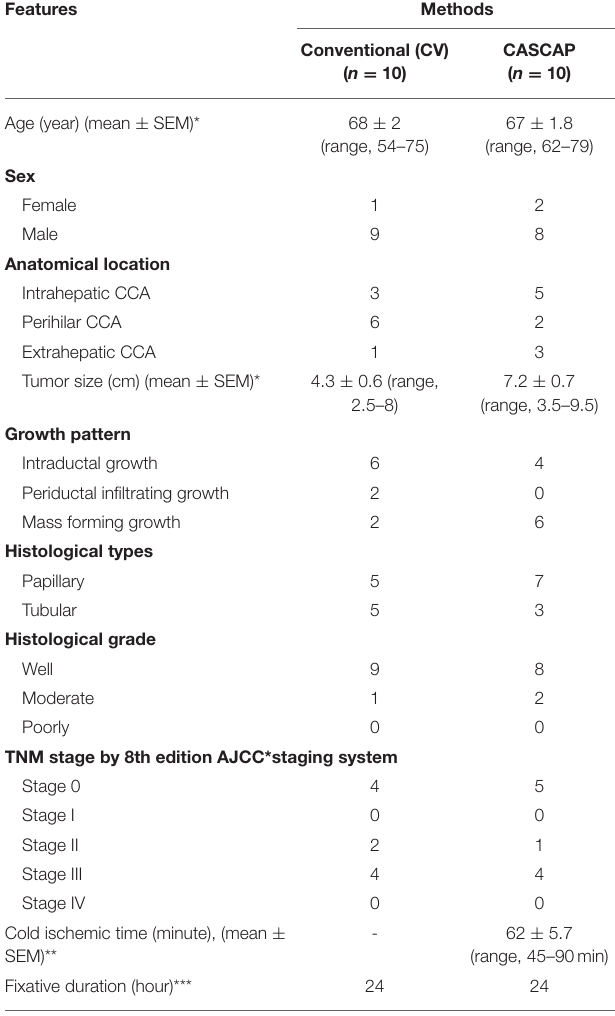
TABLE 1 | Criteria of histomorphology assessment. Morphology